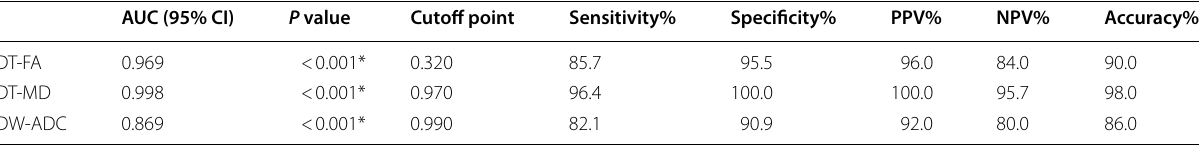
*Highly significant